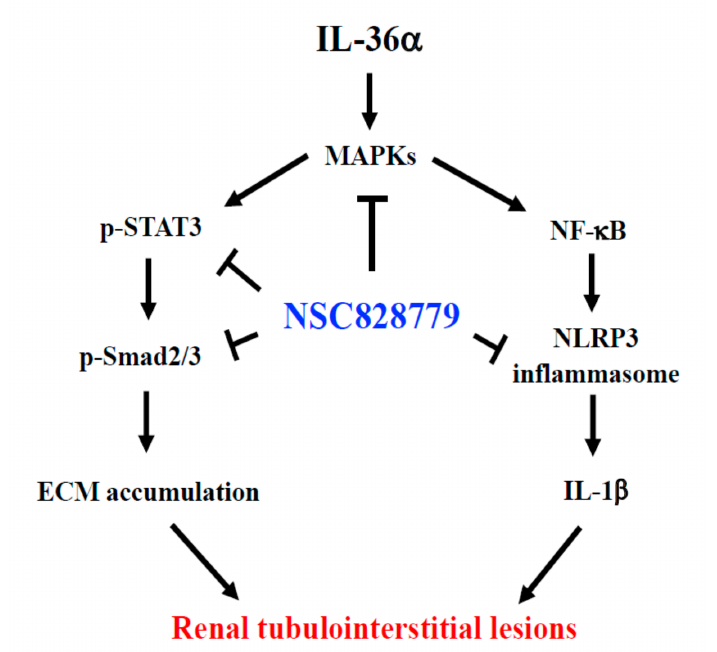
Figure 8. Schematic mechanism of action for therapeutic effects of NSC828779 on renal TILs. Treat- ment with NSC828779 improves renal inflammation and fibrosis in UUO model through a mechanism of action involving the IL-36 α -activated MAPK/NLRP3 inflammasome and STAT3- and Smad2/3- dependent fibrogenic signaling. NSC828779, a salicylanilide derivative. UUO, unilateral ureter obstruction TILs, tubulointerstitial lesions. ECM, extracellular